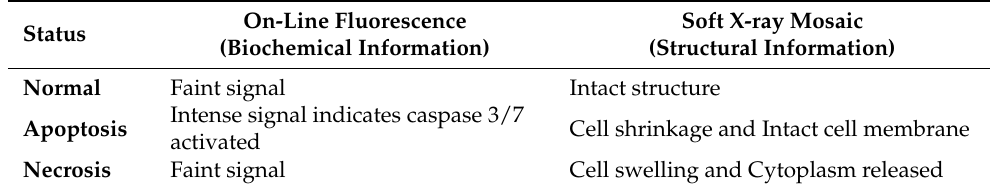
Table 1. Criterion for determining cell status on-line.